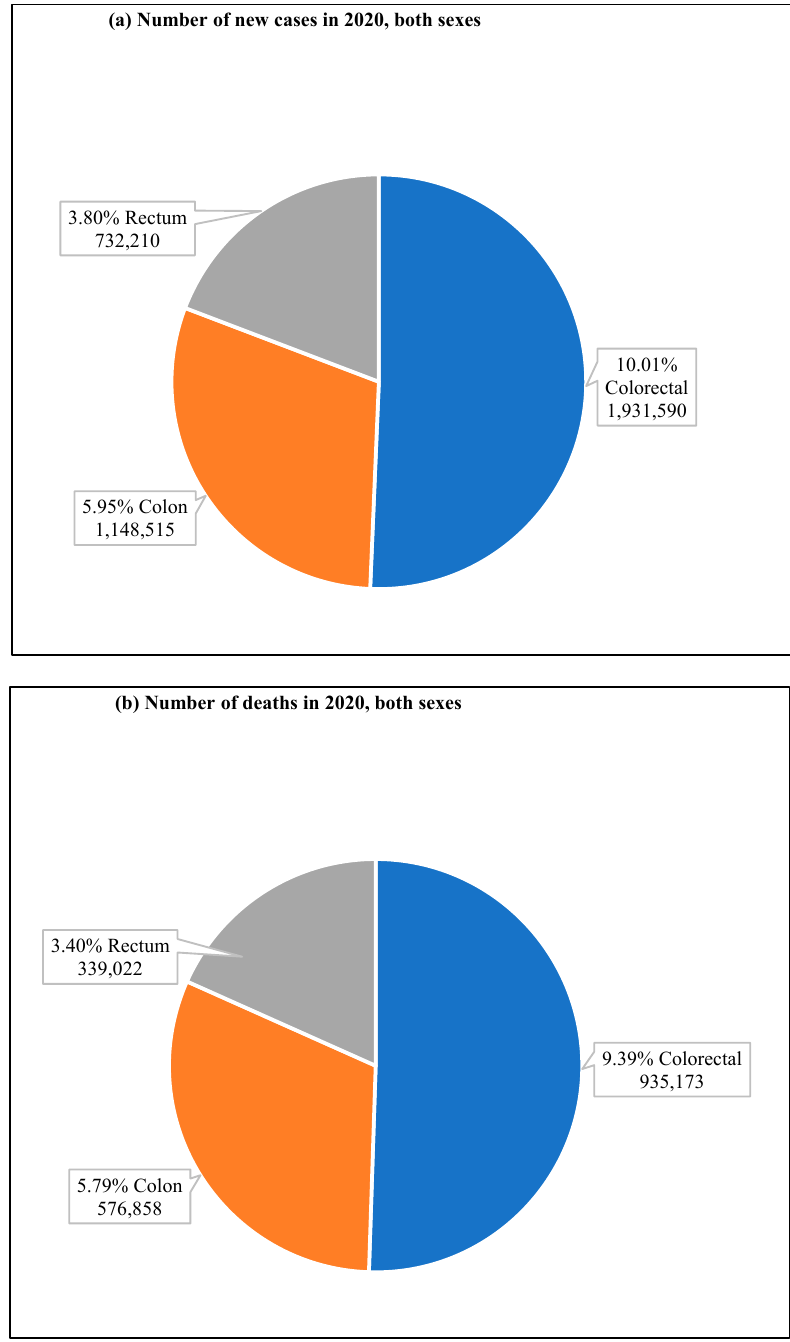
Figure 2. CRC new cases and deaths in 2020. ( a ) shows new cases, both sexes and all ages, and ( b ) shows deaths of both sexes for all age groups. The value shown in % is calculated against the total number of all cancers. The data source is GLOBOCAN [25], taken with permission.